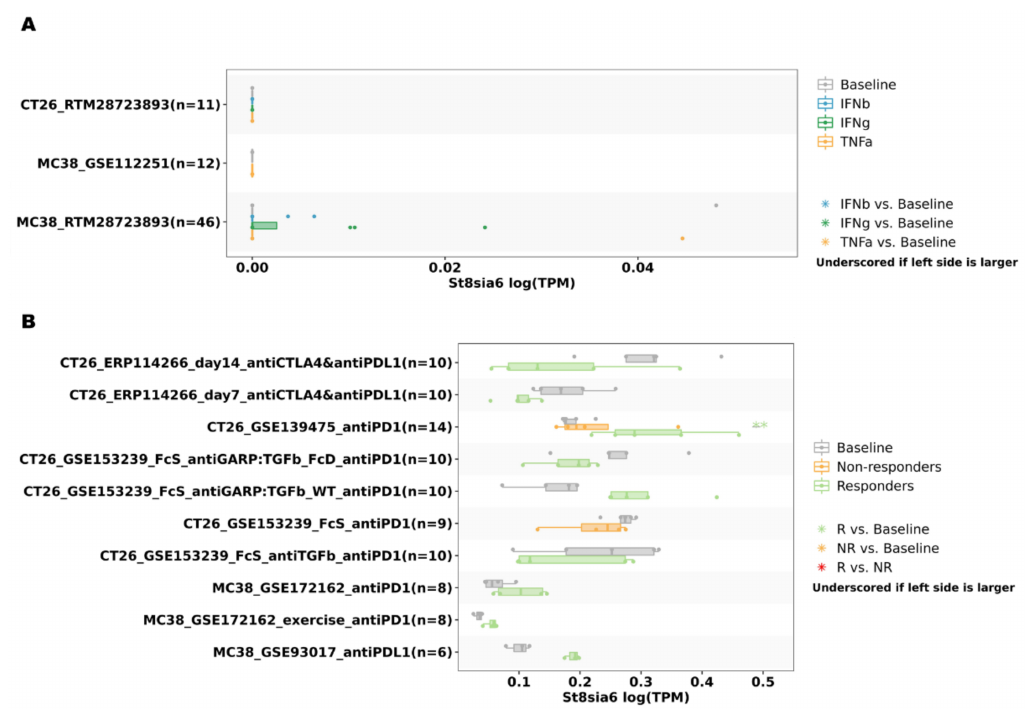
Figure 7. Correlations of ST8SIA6 expression with cytokine treatment and immunotherapy response in CT26 and MC38 colon cancer cells. ( A ) ST8SIA6 expression is not significantly related to interferon gamma, interferon beta, and TNF alpha treatment in the CT26 and MC38 colon cancer models. ( B ) ST8SIA6 expression in CT26 or MC38 colon cancer model is stimulated by different immune- checkpoint blockade (ICB) treatments. Boxplot showing ST8SIA6 expression before and after cytokine treatments and ICB treatments in different comparison conditions. p -value Significant Codes, ** <0.01, compared with baseline